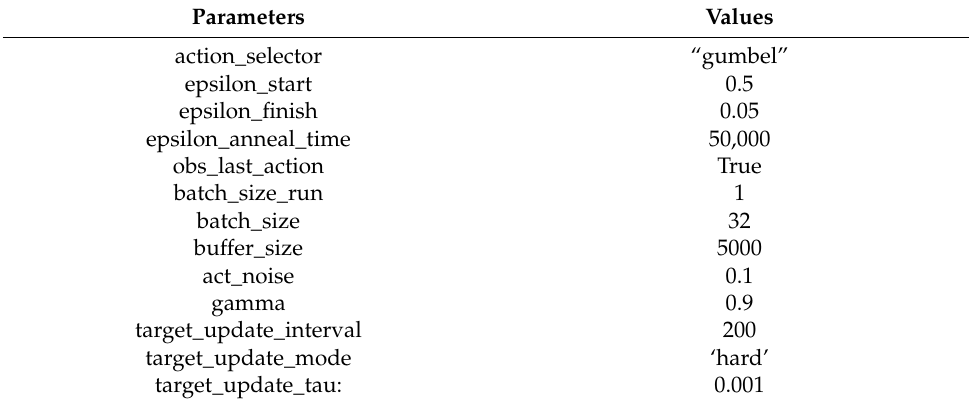
Table 5. The parameters of